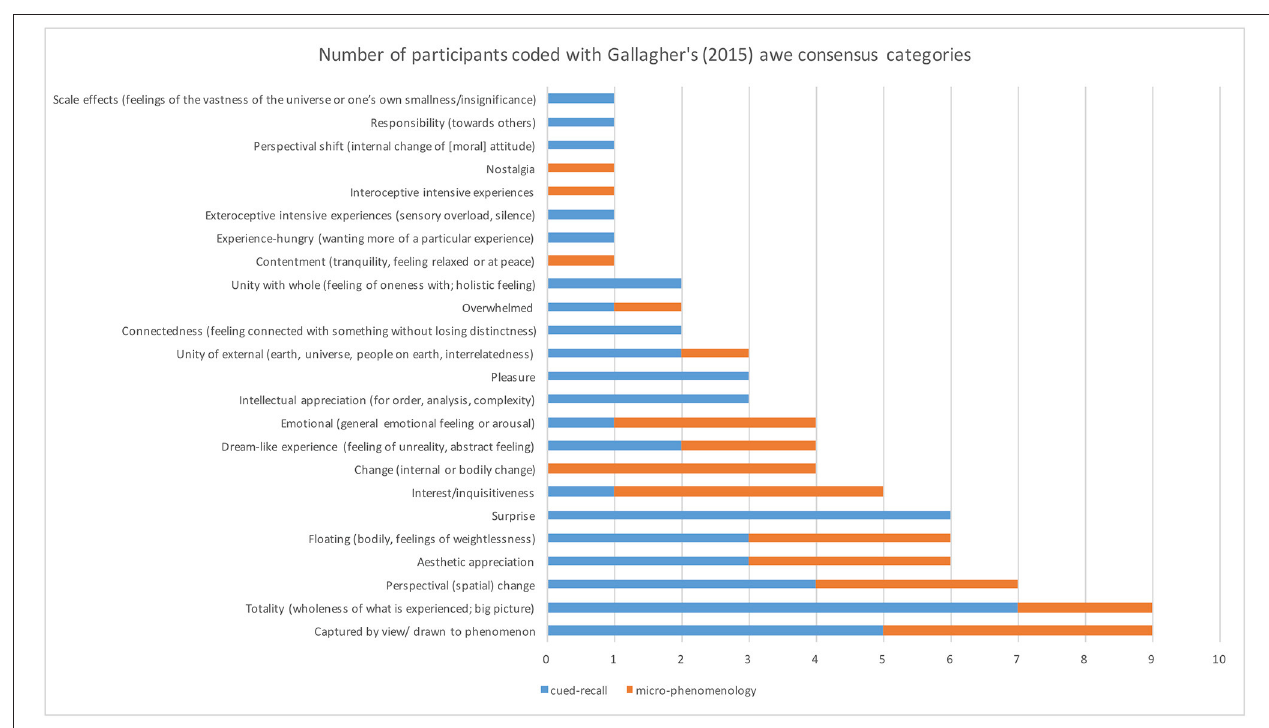
FIGURE 7 | The number of participants, that had statements coded with hermeneutics analyses of categories of awe (Gallagher et al.,